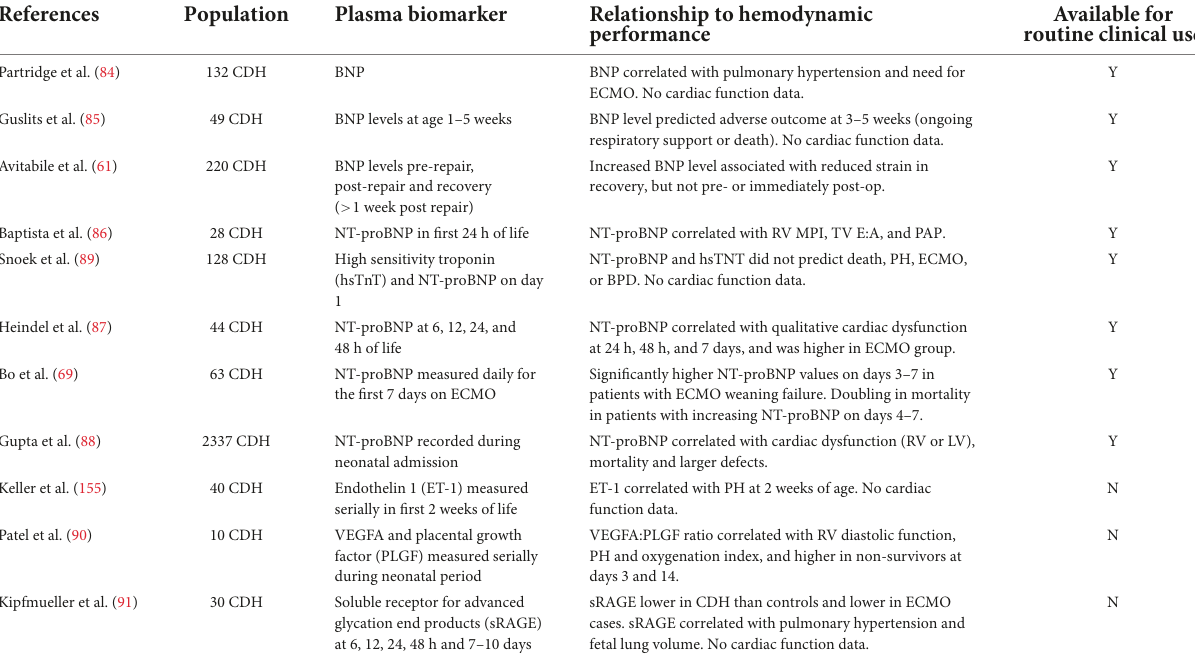
TABLE 4 Investigations of biomarkers of cardiac function and pulmonary hypertension in